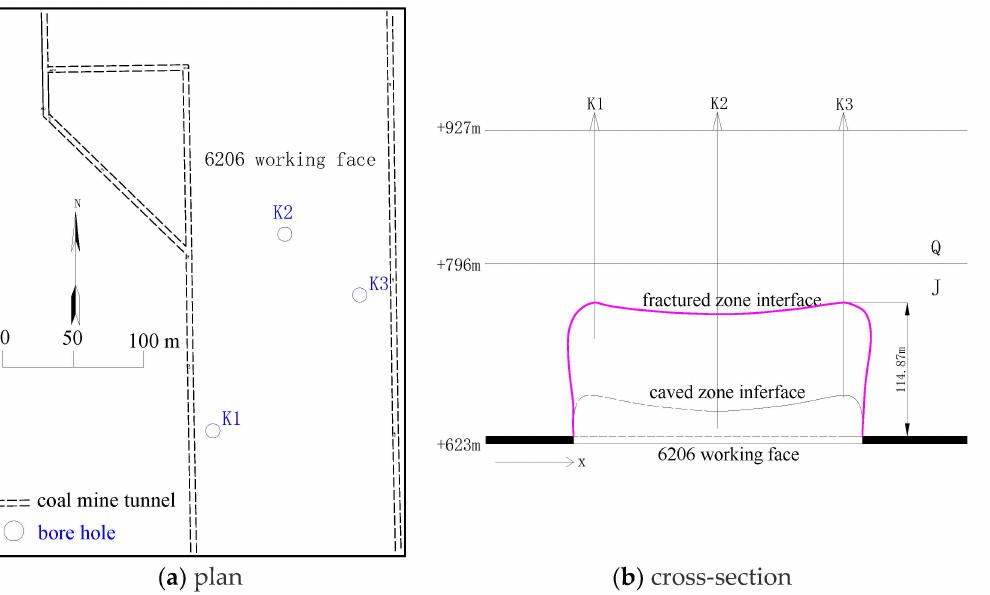
Figure 4. The locations of three drilling holes in the 6206 working face of Wangzhuang Coal